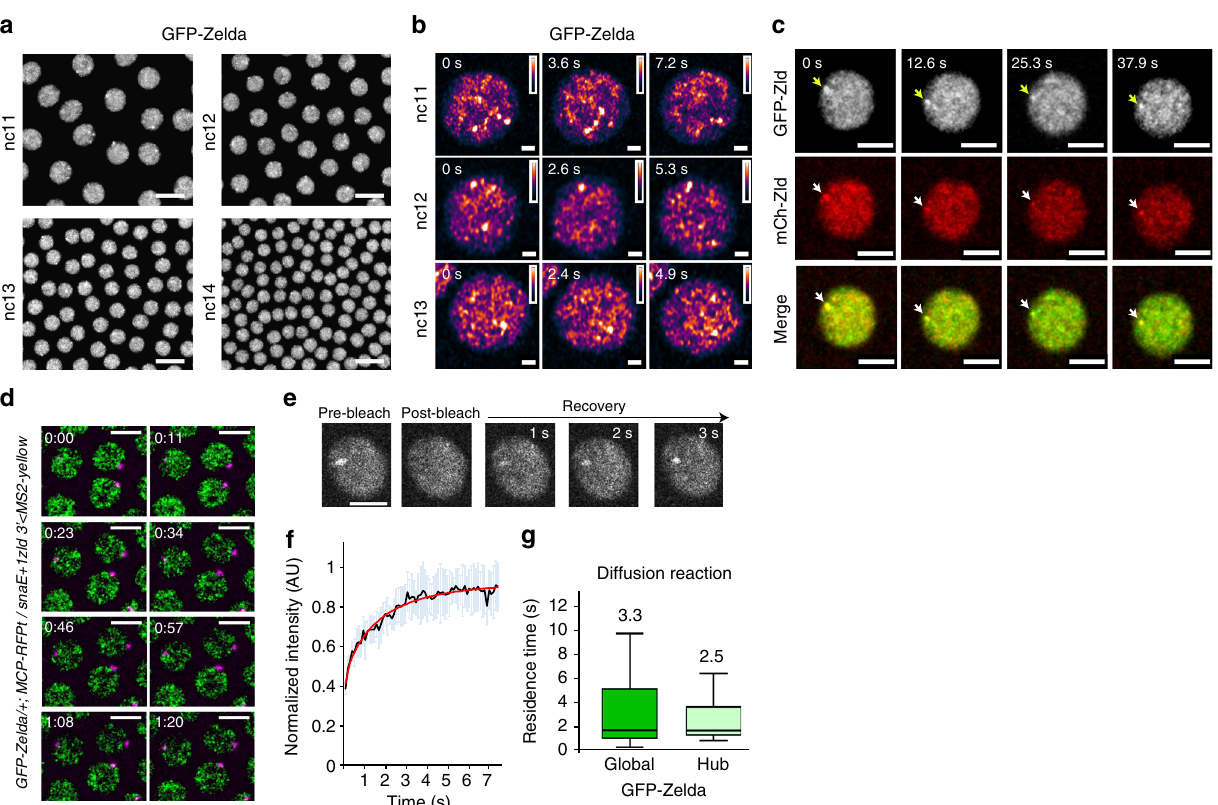
Fig. 6 Zelda hubs kinetic properties. a Living GFP-zld embryo imaged by confocal microscopy from interphase of nc11 to early interphase of nc14. Successive representative maximum intensity projected Z-stack images showing local inhomogeneities are shown at each cycle (see also Supplementary Movie 11). Scale bars represent 10 μ m. b Nuclei zoom from living GFP-zld embryos imaged by confocal microscopy from interphase of nc11 to early interphase of nc13. Successive representative images showing local hubs are shown at each cycle. Scale bars represent 1 μ m. c Nuclei zoom from living GFP-zld/mCherry-Zld embryos imaged by confocal microscopy at interphase of early nc11. Successive representative images showing Zelda subnuclear hubs are shown at each cycle (an example is indicated by an arrow). Scale bars represent 5 μ m. d Living GFP-Zld/ + ;MCP-RFPt/ + embryo containing the snaE + 1Zld3 ’ transgene (MS2 in magenta) imaged by confocal microscopy. Successive representative maximum intensity projected Z-stacks of slices containing the MS2 signal only (see also Supplementary Movie 13). Scale bars represent 5 μ m. e Example of a FRAP experiment on a single hub. f FRAP mean curve (black) and the mean of all the fi ts (red curve) using diffusion reaction models determined at the bleached spot for 11 nuclei from nc10 – 13 developing GFP-zld embryos. Error bars represent SD from different nuclei (light blue bars). Scale bars represent 5 μ m. g Box plot representing estimated residence times (1/k off ) extracted with diffusion reaction model of GFP-Zld in Global (dark green) compared to Hubs (light green). Numbers above each plot represent the mean RT. Centered lines represent the median and whiskers represent min and